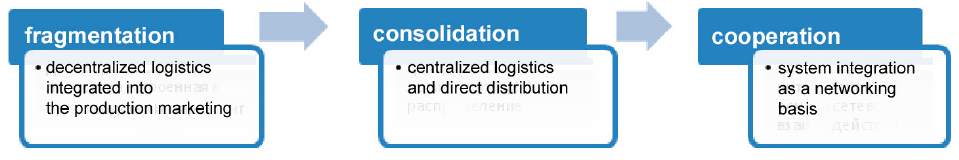
Figure 1. Logistics integration evolution.